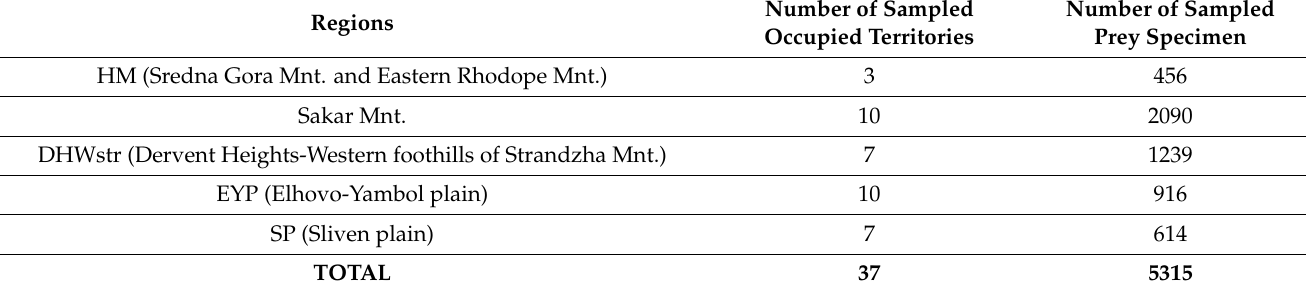
Table 1. Number of sampled prey specimens and number of sampled eastern imperial eagle occupied territories in different regions.